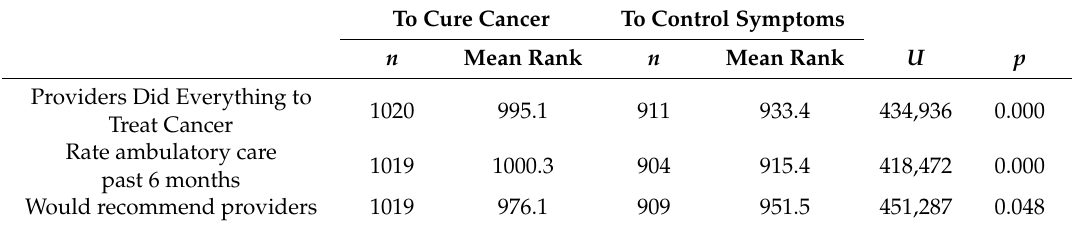
Table 3. Overall